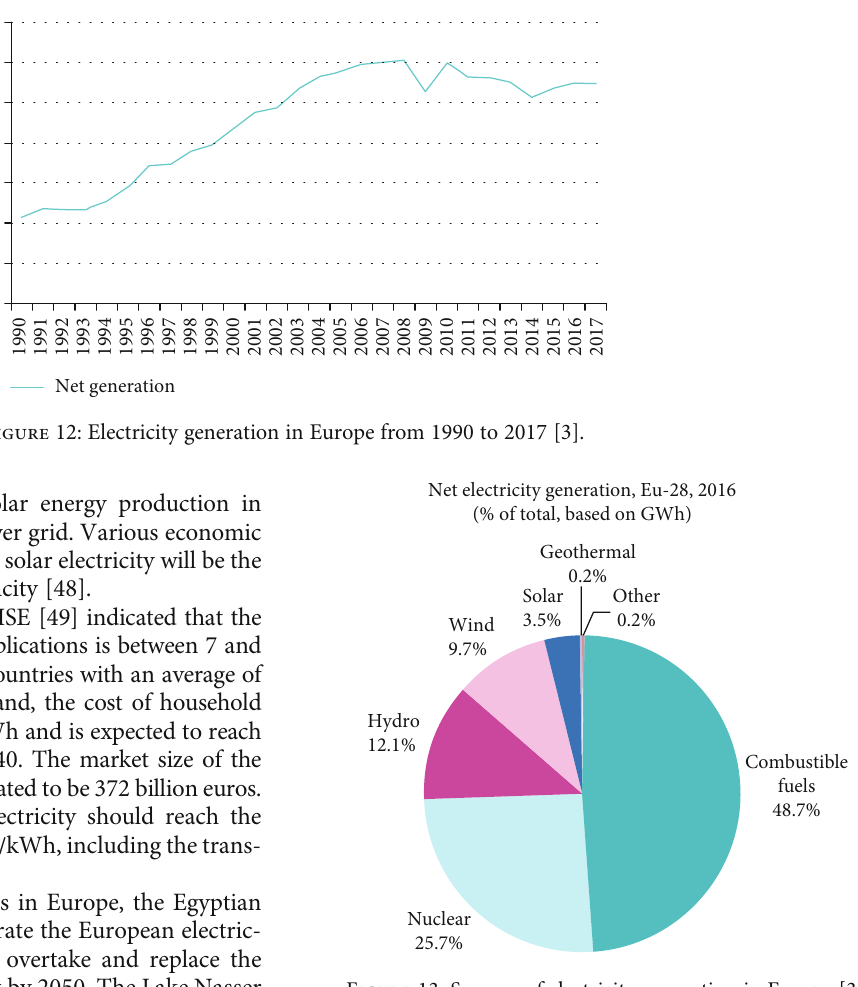
Figure 13: Sources of electricity generation in Europe